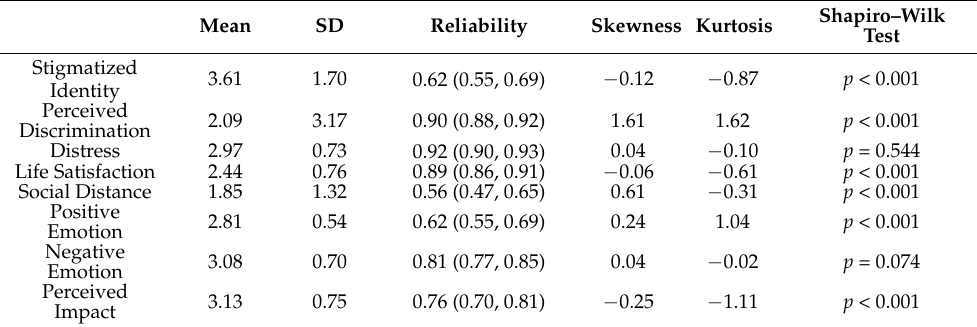
Table 2. Descriptive statistics of stigmatized identity, discrimination, and well-being measures.